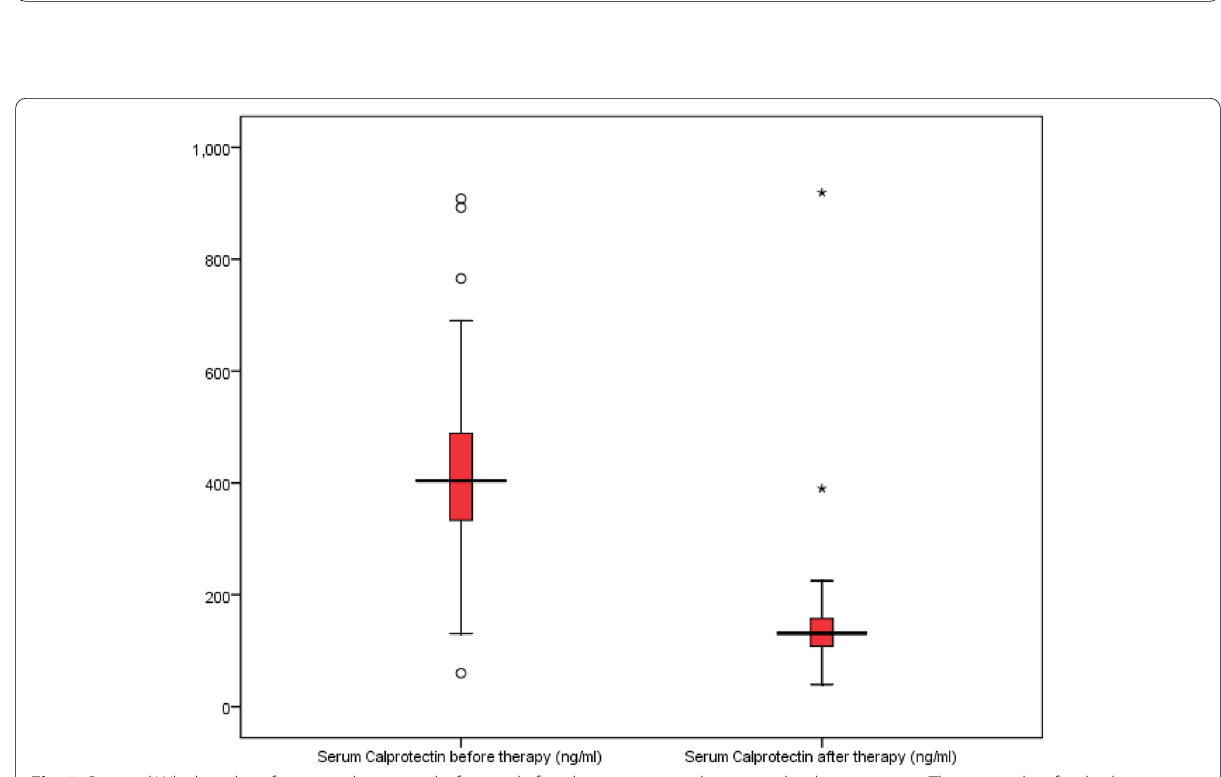
Fig. 2 Box and Whisker plot of serum calprotectin before and after therapy among rheumatoid arthritis patients. Three months after biologic therapy, a significant decline in serum calprotectin from 404.1 (60.0–908.2 ng/ml) to 131.70 (39.9–171.73 ng/ml) was observed ( P <